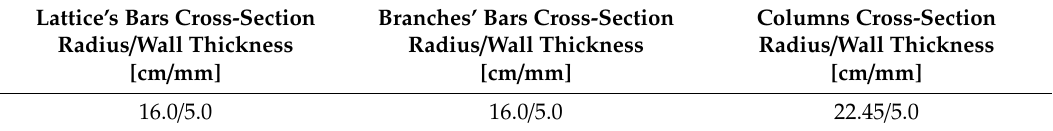
Table 6. Division of the structures’ bars and their cross